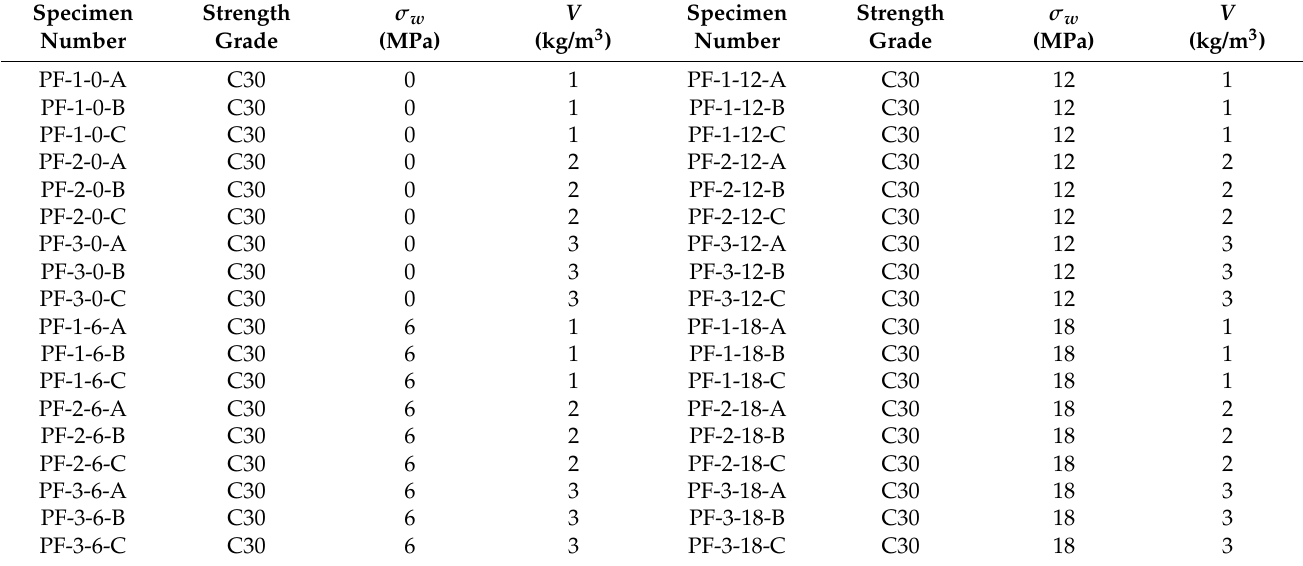
Table 5. Specimen design parameters.